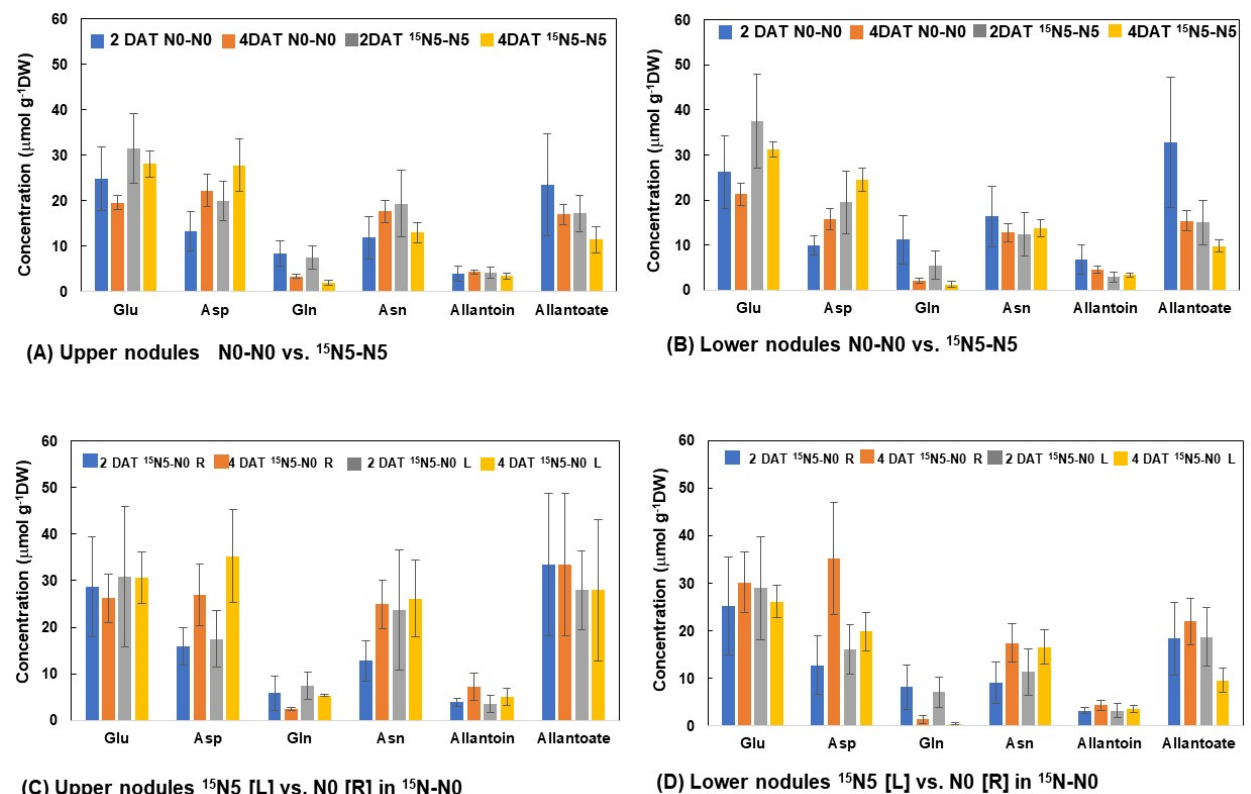
Figure 8. Comparison of the concentrations of principal N metabolites in the upper nodules and the lower nodules of soybean plants with split root experiments with N0-N0 and 15 N5-N5 treatments and the concentrations of N compounds in either half-roots supplied with N-free solution or 5 mM nitrate in 15 N5-N0 treatment. ( A ) Upper nodules, N0-N0 vs. 15 N5-N5, ( B ) Lower nodules, N0-N0 vs. 15 N5-N5, ( C ) Upper nodules, 15 N-N0, 15 N5(L) vs. N0 (R), ( D ) Lower nodules, 15 N-N0, 15 N5(L) vs. N0 (R). ( A ) N = (8), ( B ) N = (4). Average ±